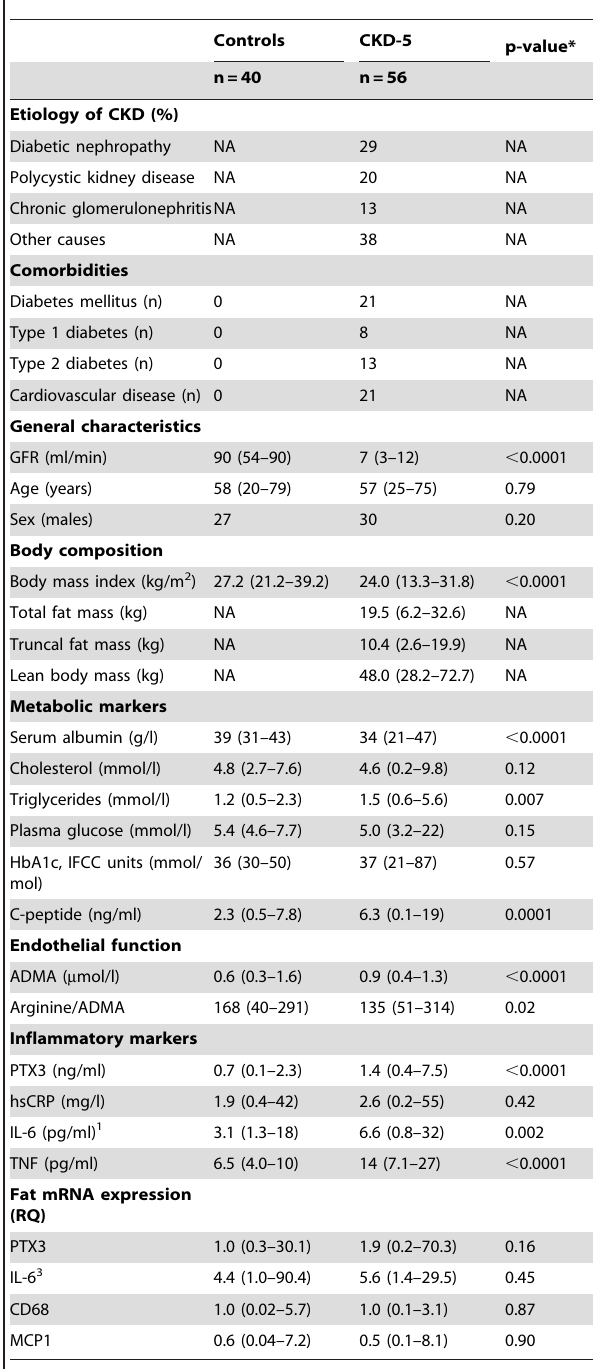
Table 1. Demography and clinical characteristics of non-CKD controls and CKD stage 5